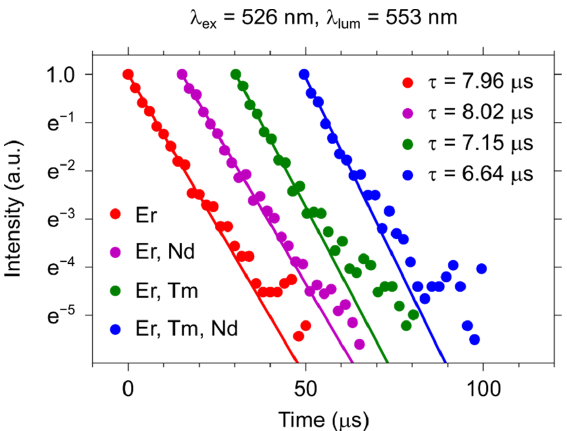
Figure 5. Luminescence decay curves of the one-, two-, and three-doped samples with the selective excitation of Er 3+ ions. The energy transfer efficiency ( η ) for the erbium-containing samples has been calcu- (cid:4673) (cid:3400) 100% , where τ da is the donor lifetime lated using the following formula: η (cid:3404) (cid:4672)1 (cid:3398) (cid:3099) (cid:3279)(cid:3276) (cid:3099) (cid:3279)